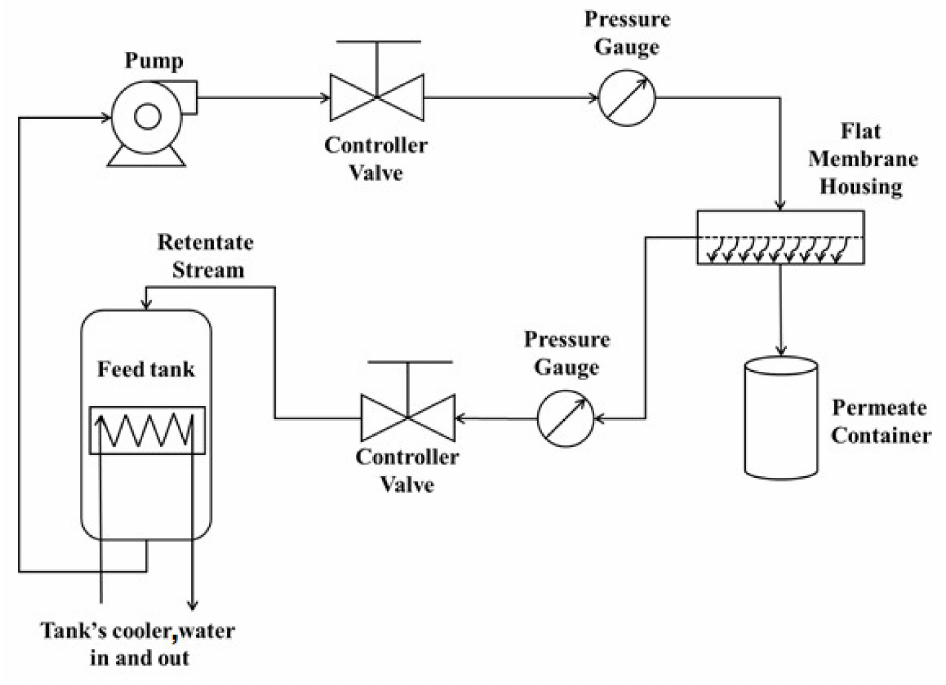
Figure 2. Schematic representation of the frontal filtration flow